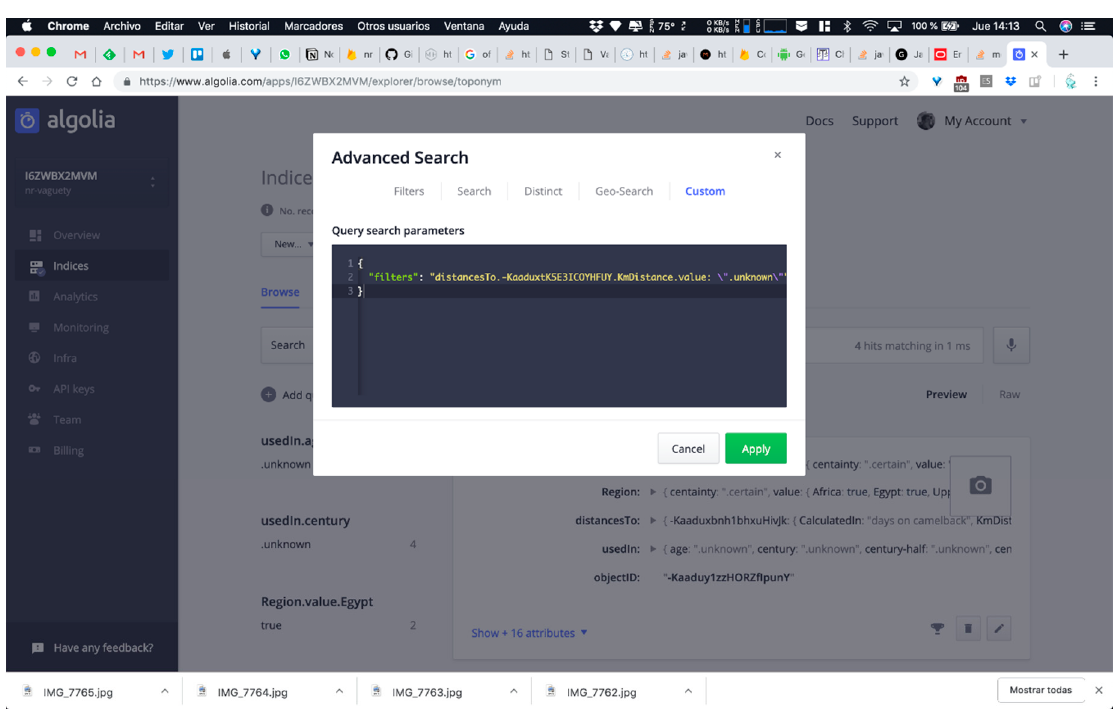
Figure 10. Query B execution using Algolia search engine. We have added custom expression on the